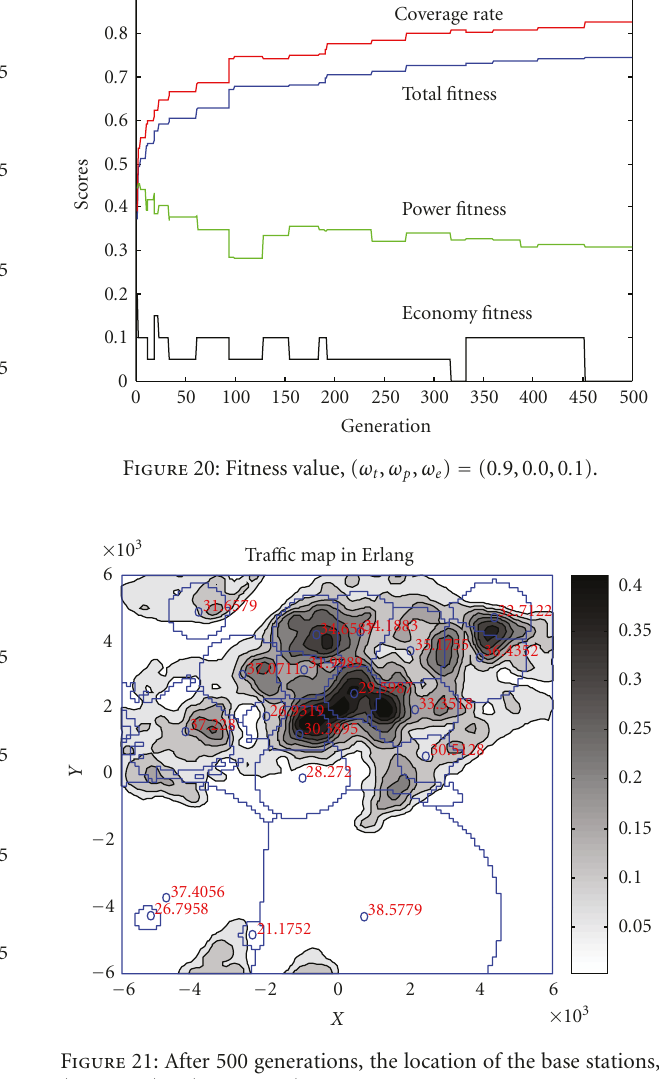
Figure 19: After 500 generations, the location of the base stations, ( ω t , ω p , ω e ) = (0 . 9,0 . 0,0 . 1).